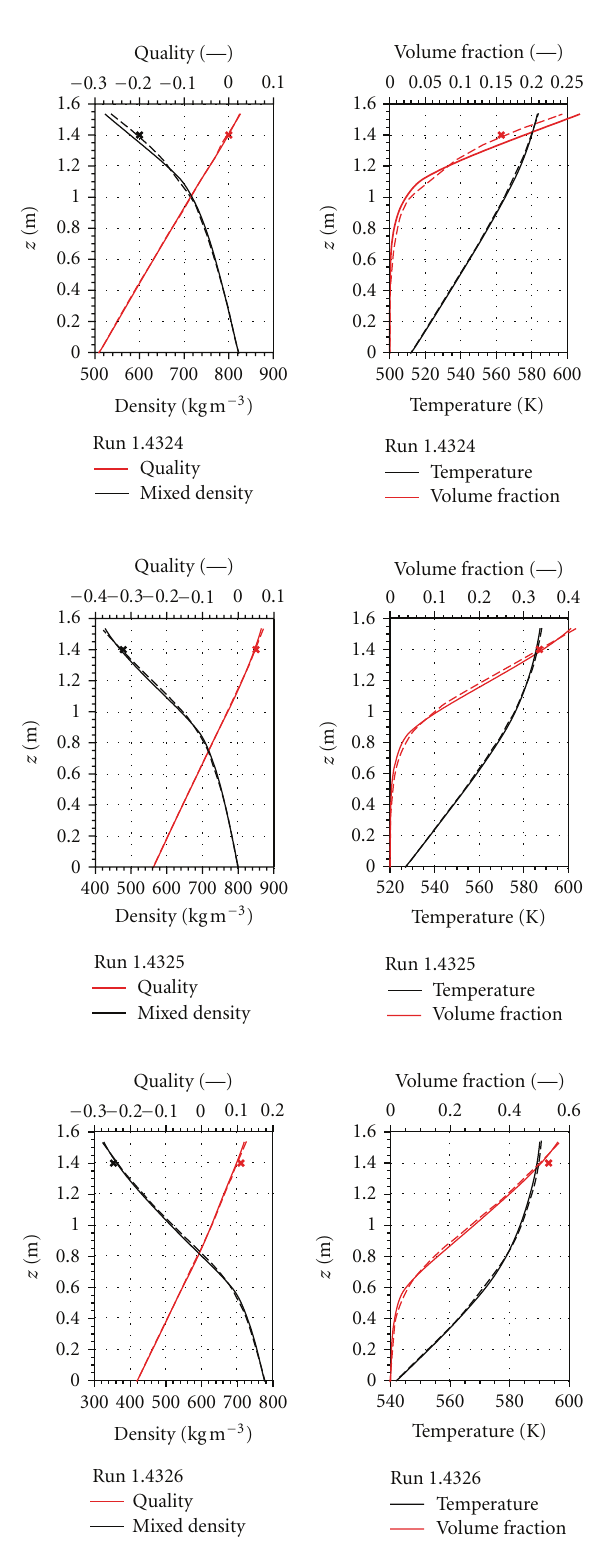
Figure 8: Cross sectionally averaged values for runs 1.4324, 1.4325, and 1.4326; solid lines: Shear Stress Turbulence model (SST), dotted lines: Reynolds Stress Turbulence model